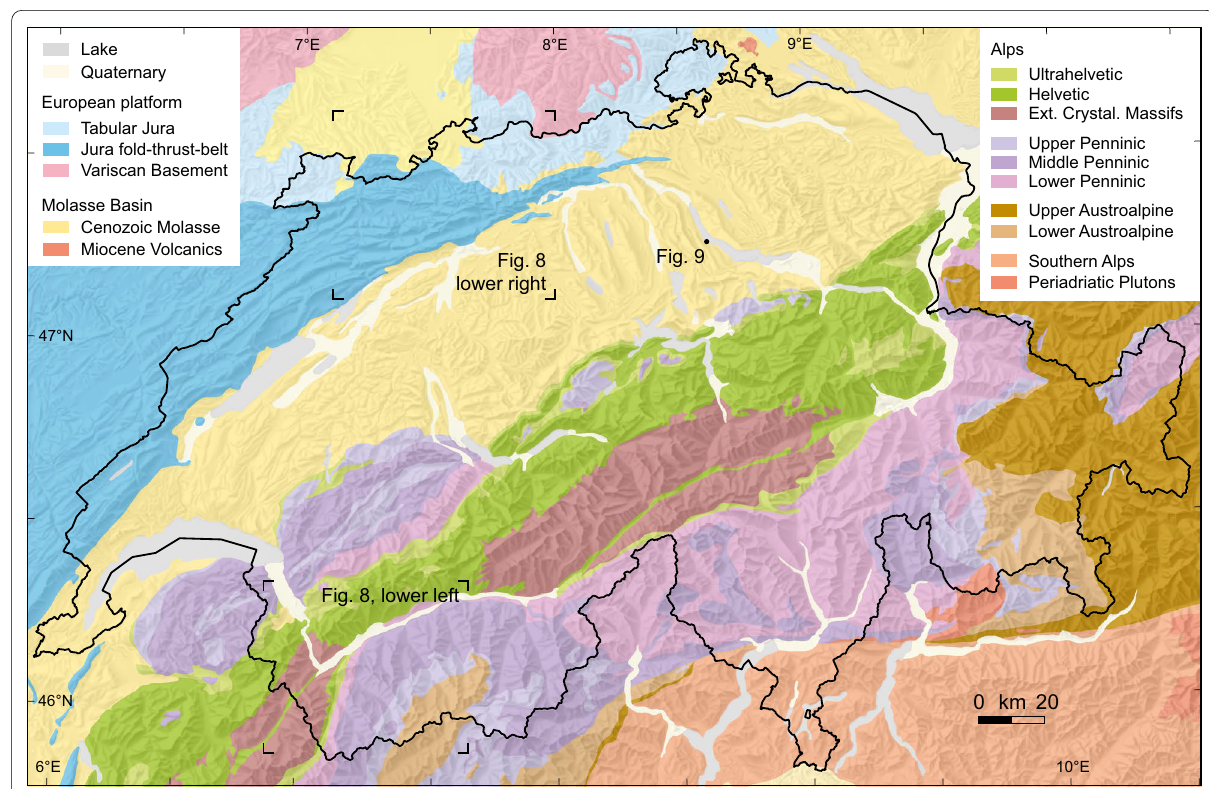
Fig. 1 Tectonic map of Switzerland illustrating the main geological domains of the European Platform, the Molasse Basin and the Alps. Note that "Cenozoic Molasse" polygons include the Cenozoic foreland basin units of the North-Alpine Molasse Basin, the Upper Rhine Graben and of the Po Basin. The Quaternary is displayed only along the main